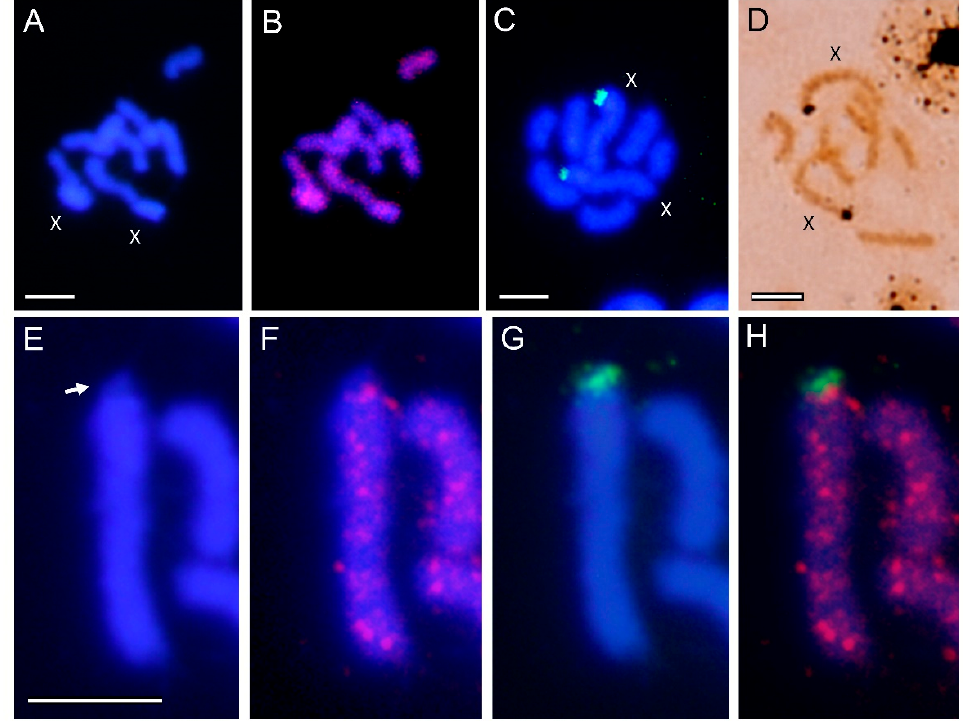
Figure 3. ( A ) Mitotic chromosomes of A. hederae after DAPI staining, ( B ) the same metaphase plate after FISH using biotin-labelled Ahedmar-Mr as a probe. ( C ) FISH using biotin-labelled rDNA as a probe showing hybridization signals in one of the terminal regions of both X chromosomes (green). ( D ) Silver staining of NORs, also reveals the position of the rDNA in the terminal regions of both X chromosomes. ( E ) Selected chromosome X showing DAPI staining, ( F ) the same chromosome after FISH using biotin-labelled Ahedmar-Mr as a probe (red), ( G ), FISH using digoxigenin-labelled rDNA as probe (green) and ( H ) merged image. The arrow indicates the terminal DAPI negative region of the X chromosomes where is located the nucleolar organizing region. Bar = 10 μ m.